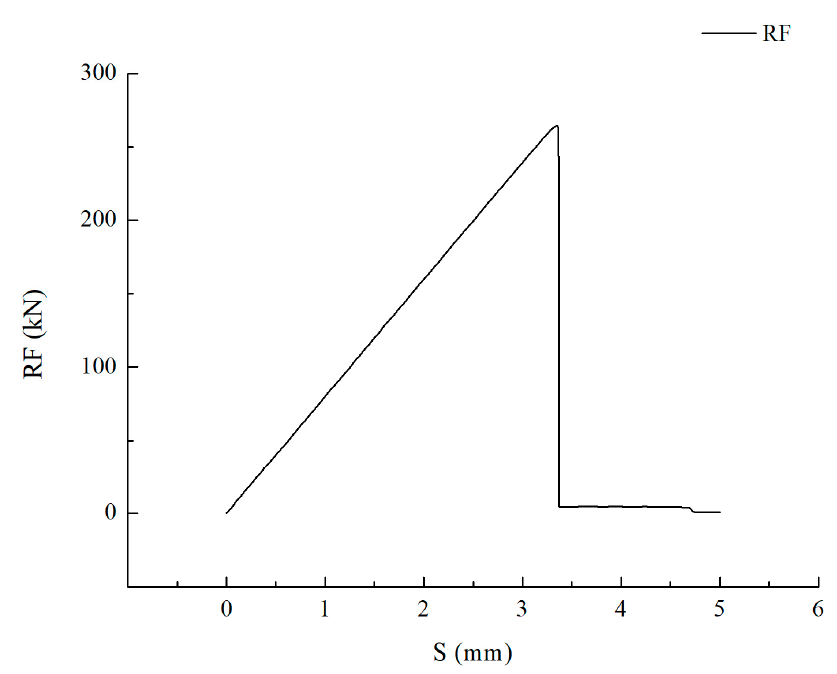
Figure 15. The relation of the reaction force of bending model with displacement load.